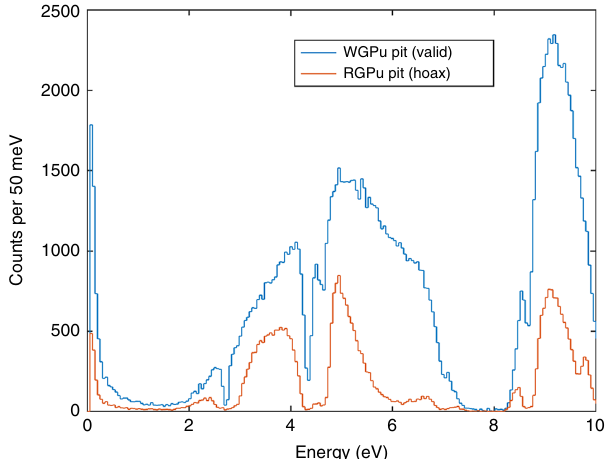
Fig. 3 Spectra from transmitted epithermal fl ux simulations. The simulations were performed for 20.7 × 10 6 neutrons incident upon a valid WPGu-reciprocal and hoax RGPu-reciprocal con fi